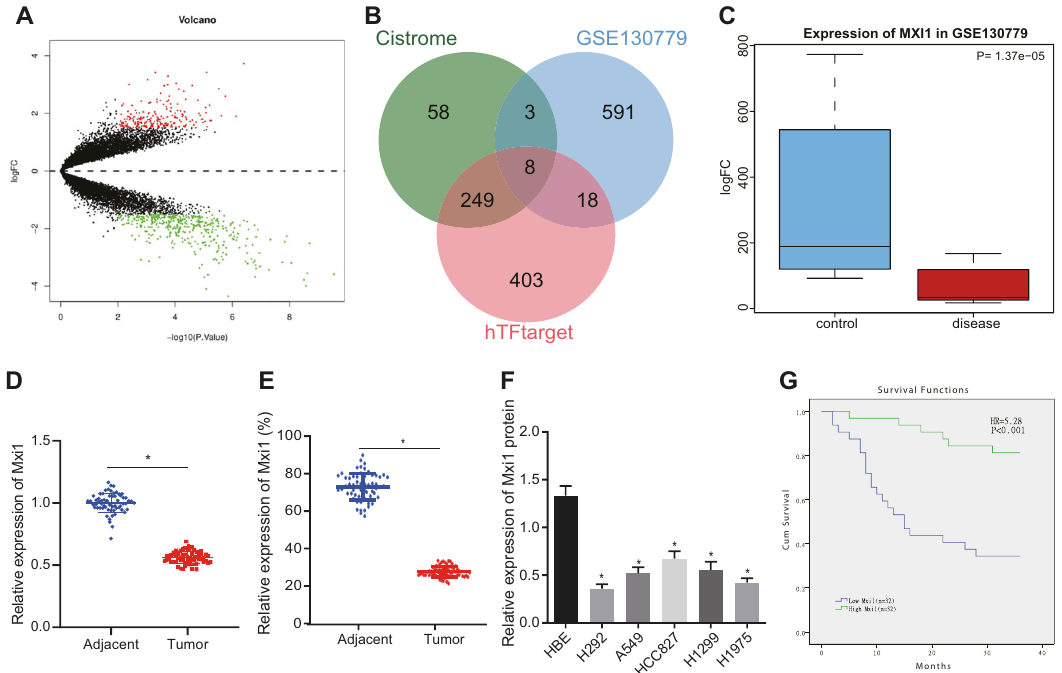
Fig. 1 Mxi1 is downregulated in lung cancer tissues and cells and is correlated with poor prognosis. A Volcano plots of the gene expression data from GSE130779, red dots: signi fi cantly upregulated genes; green dots: signi fi cantly downregulated genes; black dots: not signi fi cantly changed genes. B Venn diagram displaying interactions of DEG of GSE130779 and transcription factors obtained from Cistrome (318) and/or hTFtarget (678). C The predicted result of GSE130779 indicating the expression of Mxi1 in lung tumors (red) and normal lung tissues (blue). D Result of RT-qPCR detecting the mRNA expression of Mxi1 in lung tumor tissues and adjacent normal tissues ( n = 64); * p < 0.05, vs. adjacent normal tissues; E Representative images of IHC analysis detecting the expression of Mxi1 in lung tumor tissues and adjacent normal tissues ( n = 64); * p < 0.05, vs. adjacent normal tissues; F Western blot analysis evaluating the protein expression of Mxi1 in lung cancer cell liens (H292, A549, HCC827, H1299, and H1975) and normal human bronchial epithelial line HBE; * p < 0.05, vs. HBE cell line. G Kaplan – Meier survival analysis comparing the survival difference of patients from Mxi1-high group and Mxi1-low